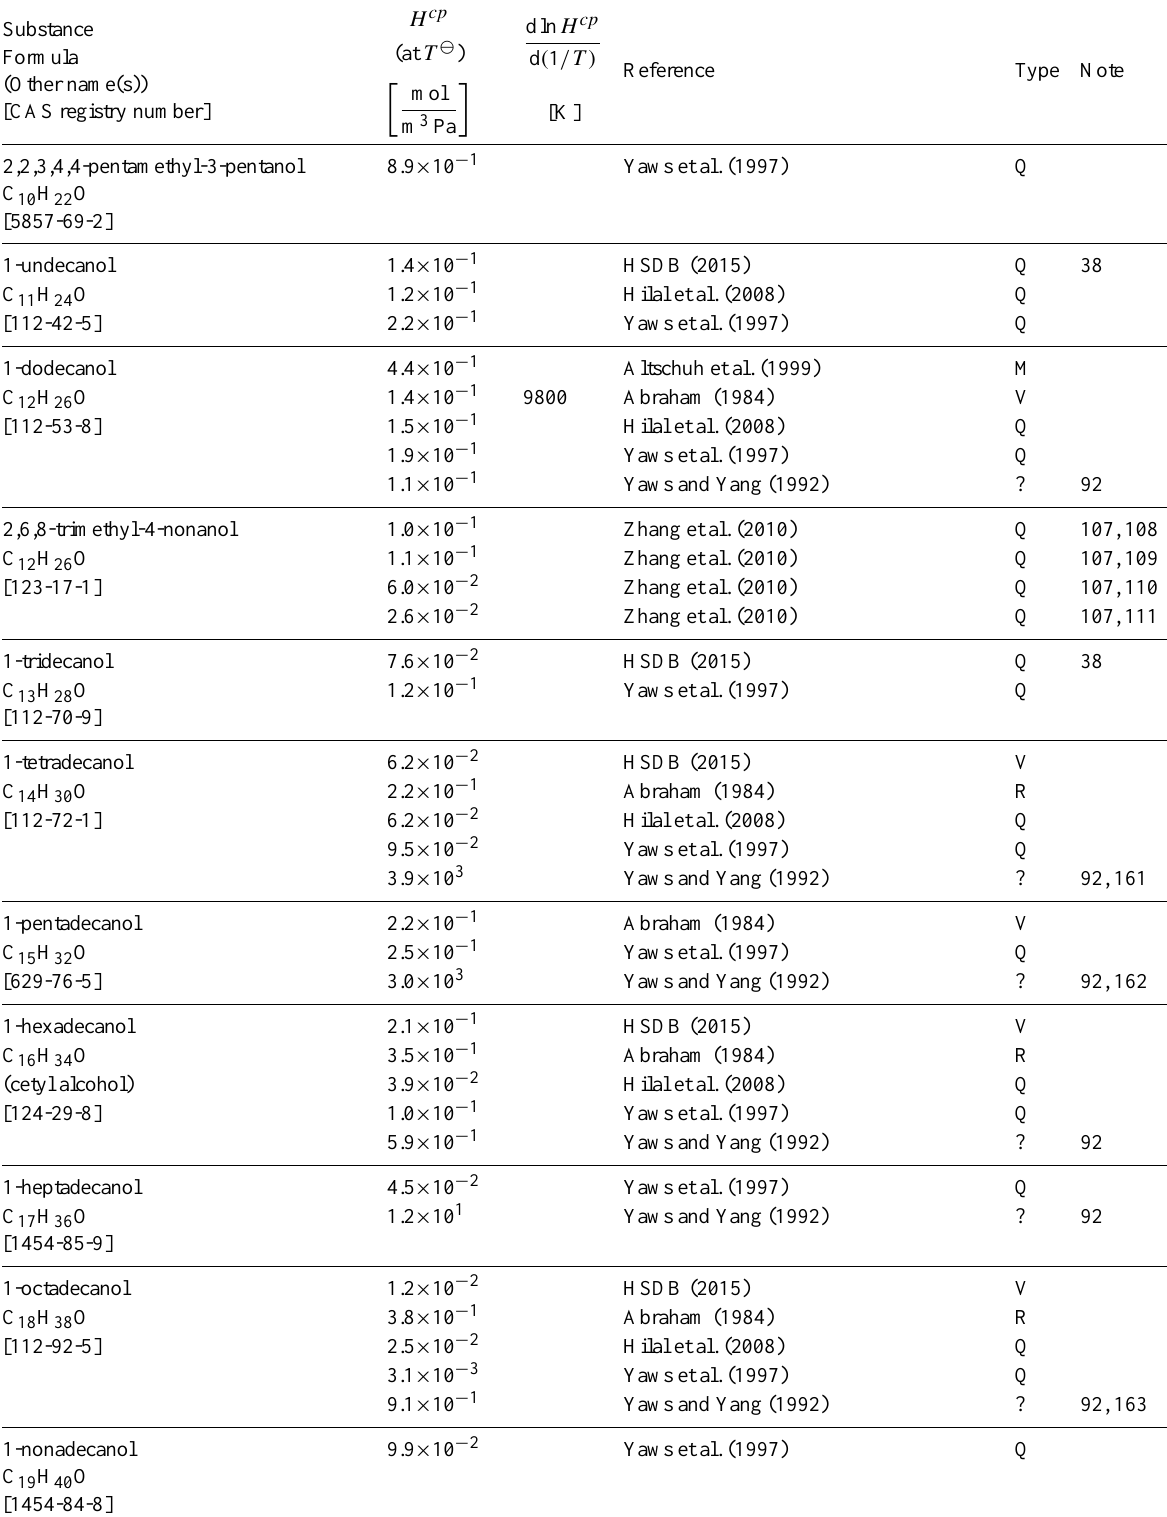
Table 6: Henry’s law constants for water as solvent